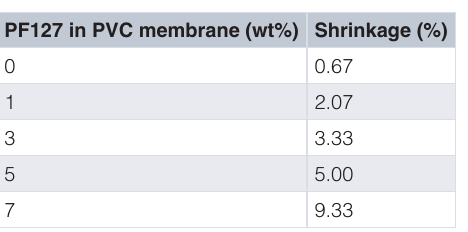
Dataset 1. Raw data for water permeability and solute rejection